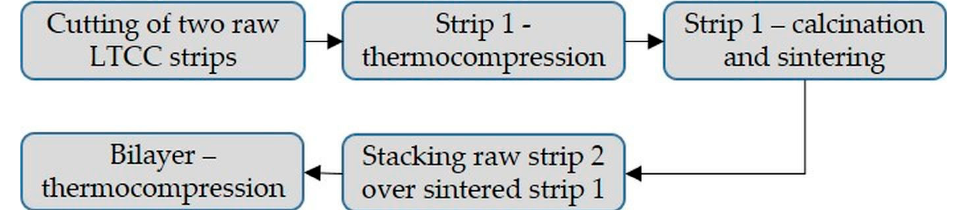
Figure 1. Synoptic summarizing the elaboration protocol of the LTCC bilayer.